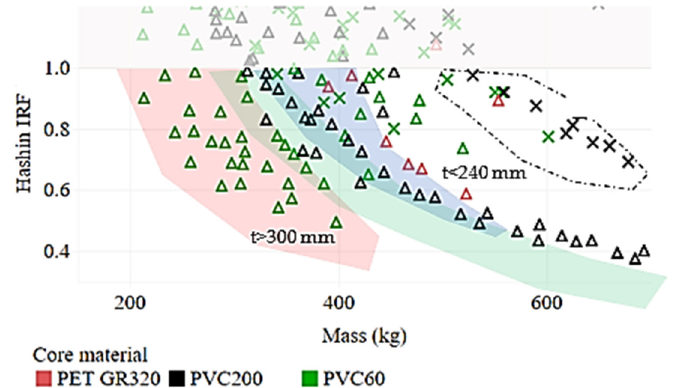
Figure 14. Interaction T4T5–Influence of face and core materials on Hashin failure criteria. The orange patch denotes low-density core while blue patches denote high-density cores. The triangles represent carbon fiber face sheets while crosses represent E-glass face sheets.